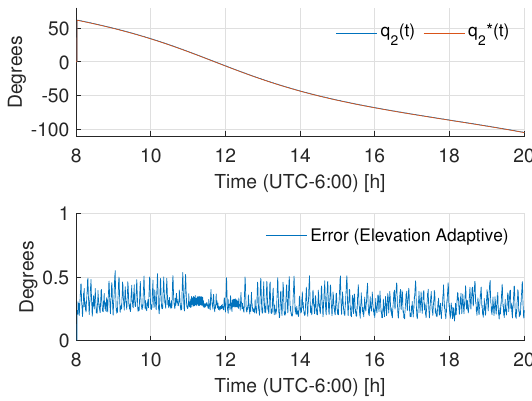
Figure 13. Tracking behavior for the elevation axis.